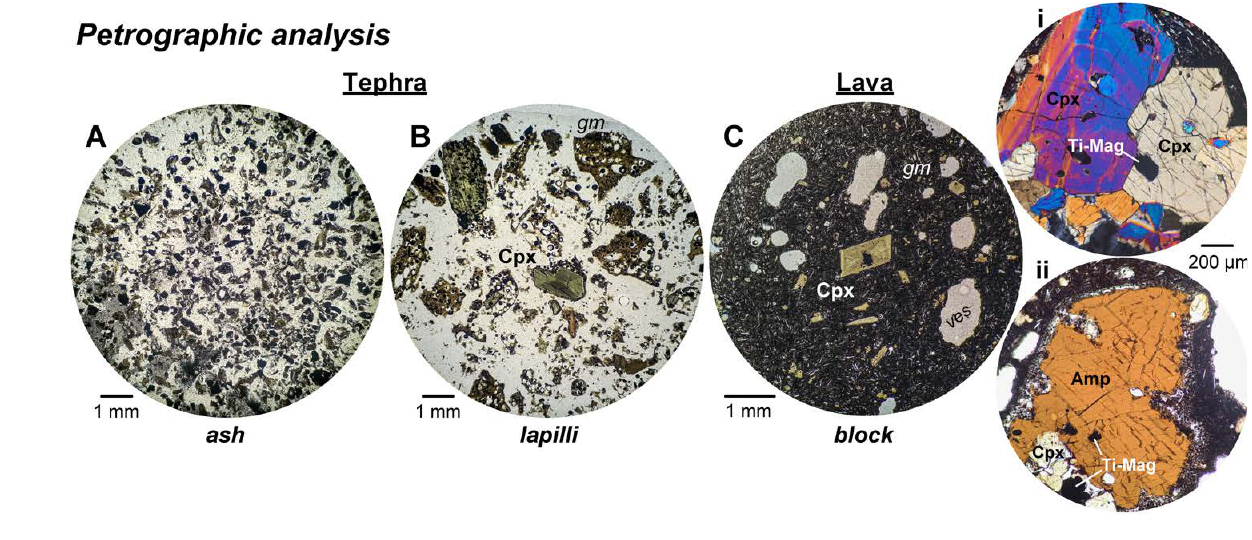
Figure 3: Photomicrographs of [A] ash; [B] lapilli and [C] lava (i) possible xenoliths with 120° grain boundaries (ii) amphibole with distinct reaction rim. Abbreviations: Cpx = clinopyroxene; Amp = amphibole, Ti-mag = titanomag- netite; gm = groundmass; Ves = vesicles.